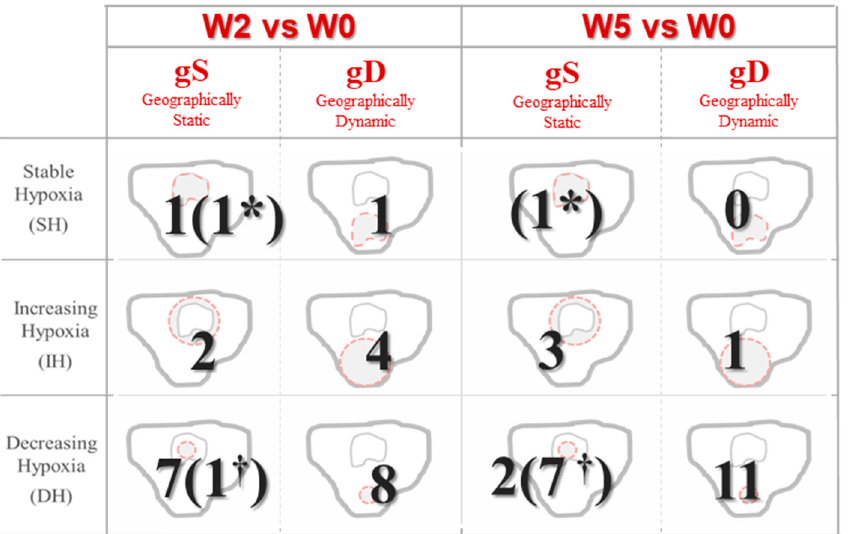
Figure 2. Status classification based on variations during treatment in size and localization of hypoxic volumes. Patients without hypoxic volume in the current time-frame by † and patients without hypoxic volume at both W0 and the current time-frame are represented by *.